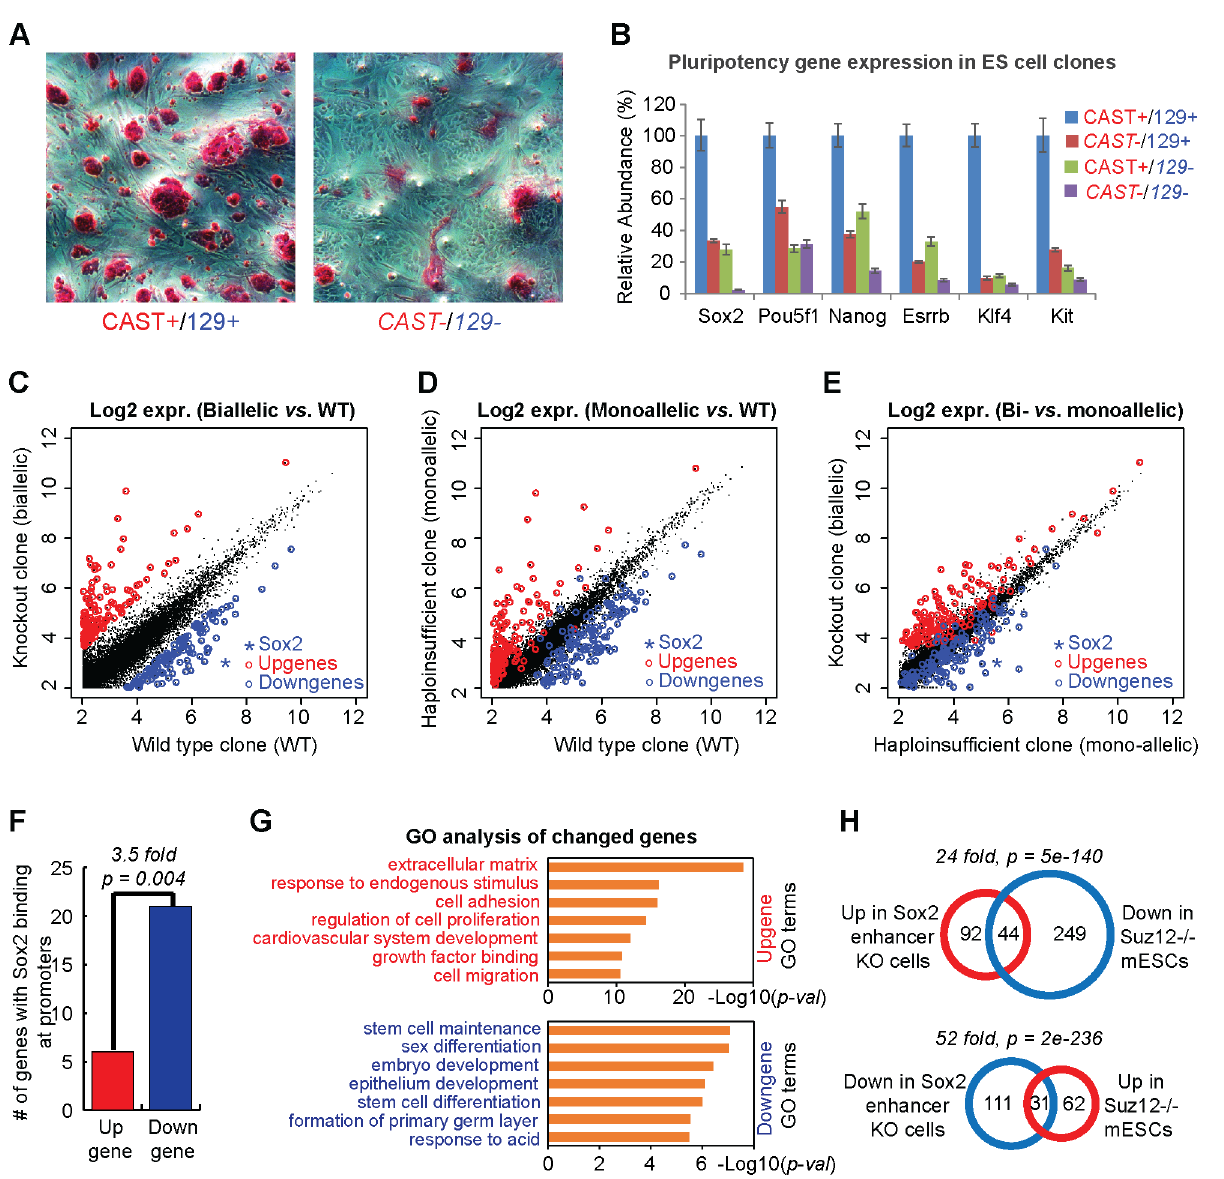
Figure 5. Sox2-SE distal deletion affects key pluripotency genes. ( A ) Alkaline phosphatase staining of wild type (left) and biallelic Sox2-SE distal deletion (right) clones. ( B ) RT-qPCR analysis of pluripotency genes in 4 representative wild type (WT) or Sox2-SE distal deletion clones. ( C–E ) Scatter plots comparing the expression levels of all mouse genes in different Sox2-SE distal deletion clones according to RNA-seq data. Knockout clone: biallelic Sox2-SE distal mutant; haploinsufficient clone: monoallelic Sox2-SE distal mutant. Plotted are log2 scaled FPKM values for each gene after adding a pseudo-value of 4. Signature up-regulated (red spots) or down-regulated (blue spots) genes were identified from the biallelic mutant clone ( C ). Expression levels of these signature genes were also compared in ( D ) and ( E ). ( F ) Bar graph comparing the up-regulated and down-regulated signature genes with Sox2 binding at promoters as called by Sox2 ChIP-seq data. P-value: Binomial test. ( G ) GO analysis identified top GO terms enriched in up-regulated or down-regulated genes upon Sox2- SE distal deletion. ( H ) Venn diagrams comparing the Sox2-SE distal knockout signature genes to signature genes found in Suz12 knockout mouse ESCs. P- value: binomial